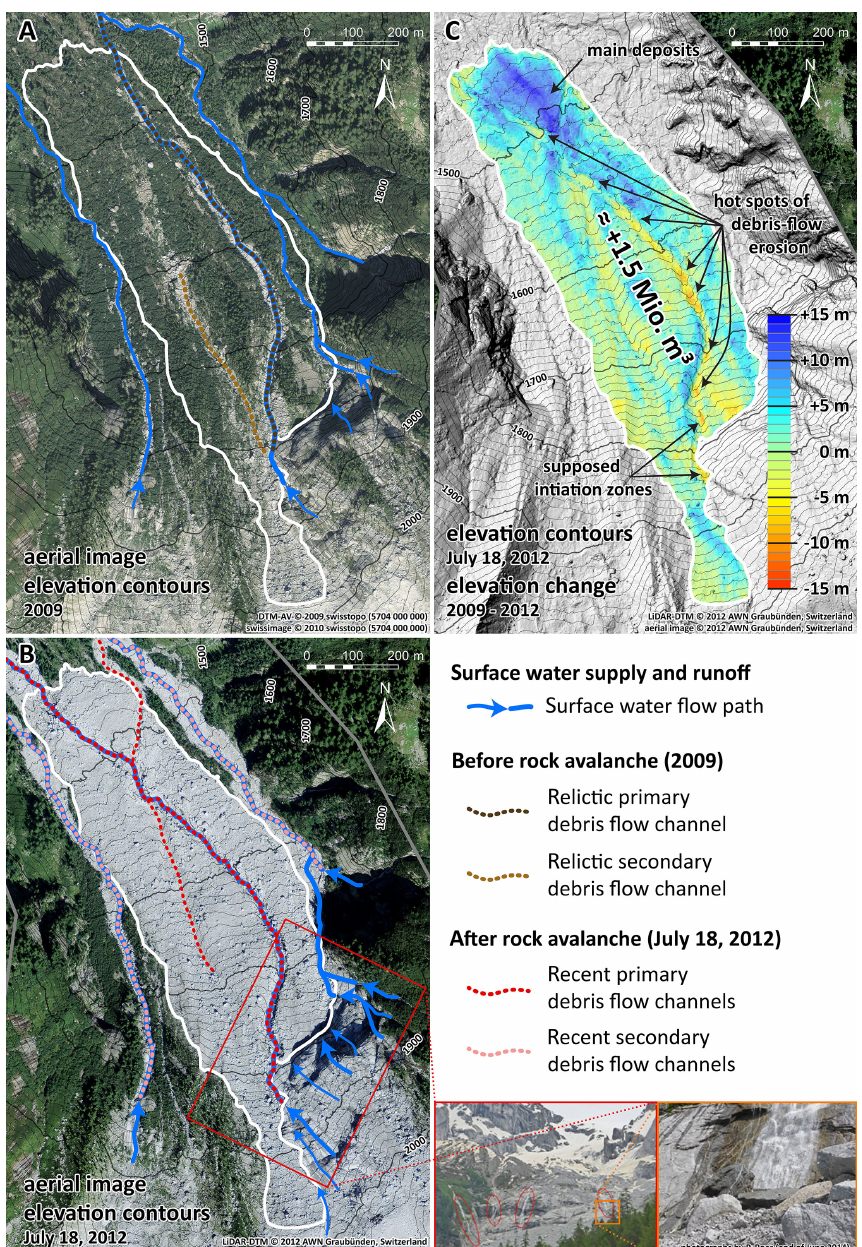
Figure 5. Overview of rock avalanche deposits, subsequently formed debris-flow channels, and the resulting overall elevation change in the Bondasca catchment (a, b) . The elevation change map 2009 to 2012 (c) includes both the rock avalanche ( ≈ 1.5 millionm 3 on 27 Decem- ber 2011) and the first two debris-flow events (5 and 14 July